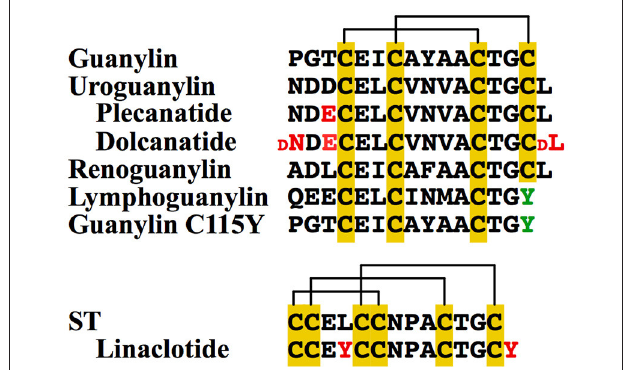
FIGURE 3 | GUCY2C Ligands. The four members of the guanylin protein family are guanylin and uroguanylin, found in humans, and renoguanylin and lymphoguanylin, found in other species. While the first three have a structural conformation characterized by two disulfide bonds (yellow), lymphoguanylin lacks the C-terminal cysteine (green), and therefore has only one disulfide bond. A mutant guanylin (C115Y) similarly has only one disulfide bond and lower potency of GUCY2C activation. In contrast, bacterial ST is characterized by a rigid structure with three disulfide bonds. Synthetic GUCY2C agonists include plecanatide and dolcanatide (uroguanylin analogs), and linaclotide (ST analog). Amino acid differences between these analogs and the parent compound are shown in